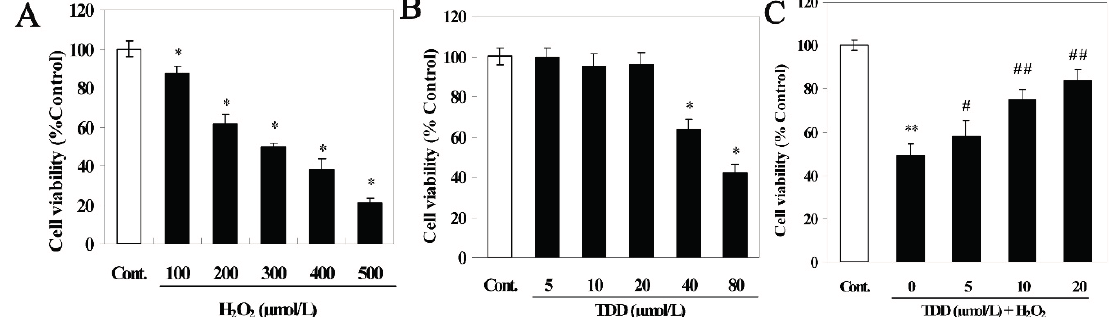
Figure 2. Protective activity of 2,4 ′ ,5 ′ -trihydroxyl-5,2 ′ -dibromo diphenylmethanone was measured by the MTT assay. ( A ) Cell viability of EA.hy926 cells treated with different concentration of H 2 O 2 ; ( B ) Cell viability of EA.hy926 cells treated with different concentration of TDD; ( C ) Cell viability of EA.hy926 cells treated with TDD followed by H 2 O 2 treatment. Data are presented as mean ± SD ( n = 6). * p < 0.05 and ** p < 0.01 vs. control; # p < 0.05 and ## p < 0.01 vs. H 2 O 2